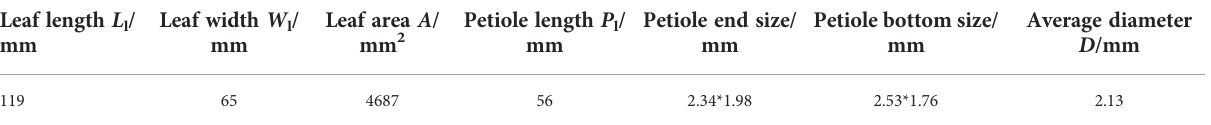
TABLE 1 Size of the pear leaf.